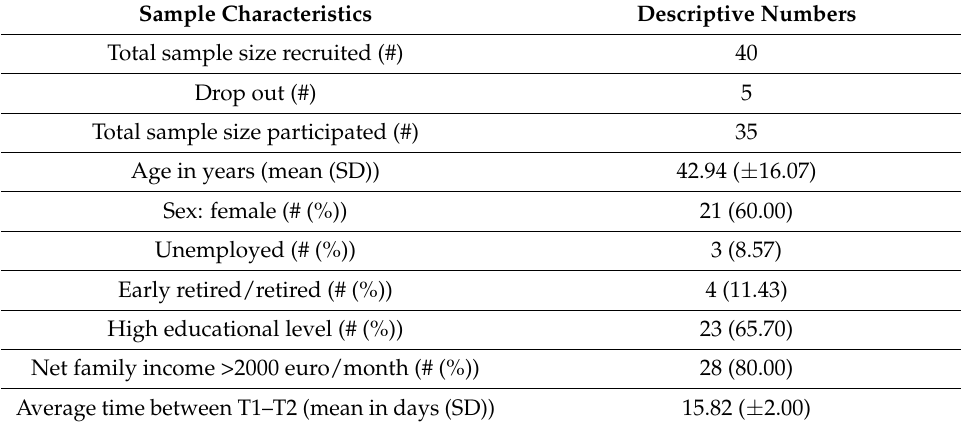
Table 1. Sample characteristics.